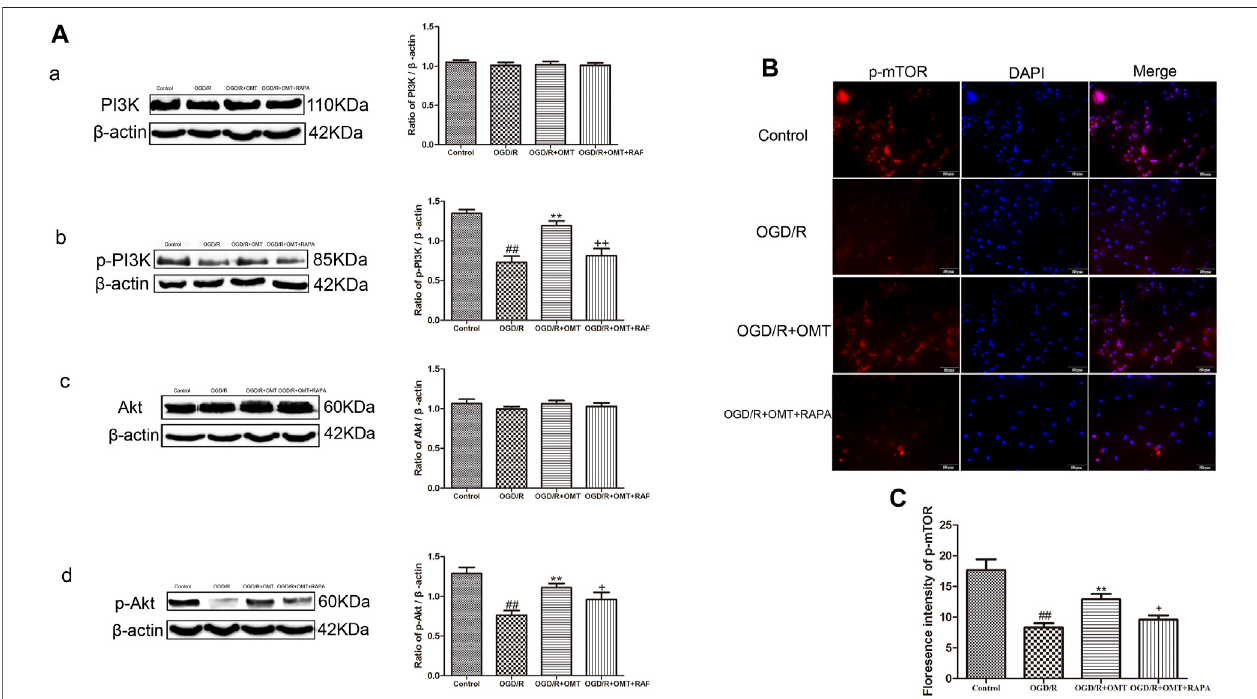
FIGURE 6 | Assessment of the expression levels of ( p )-PI3K ( p )-Akt, and p-mTOR in the ischemic hemisphere in the neonatal rats at 24 h after oxygen-glucose deprivationreperfusion(OGD/R). (A) RepresentativeWesternblotsandquantitativeanalysesshowtheproteinexpression of (A , B) PI3Kandp-PI3K, and (C , D) Aktand p-Akt. (B) Immuno fl uorescent-stained p-mTOR in the primary hippocampal neurons at 24 h after OGD/R. (C) Analysis of fl uorescence intensity of p-mTOR. The results are expressed as mean ± SEM ( n (cid:1) 6 per group). ## p < 0.01 vs. the sham group; * p < 0.05, ** p < 0.01 vs. the HI group; and + p < 0.05 vs. the oxymatrine (OMT)